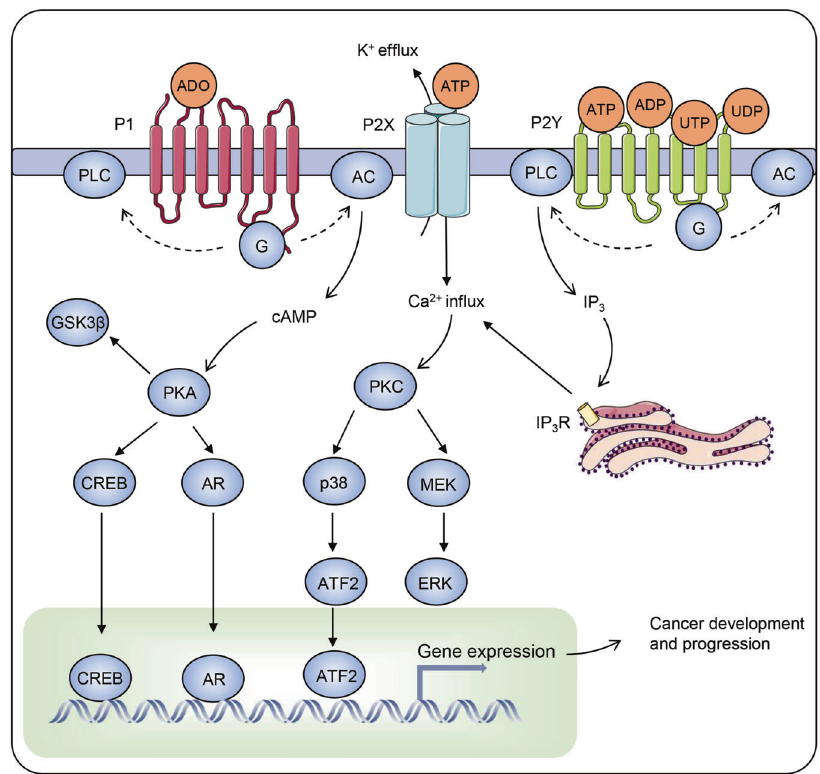
Fig. 6 Purinergic signalling involved in the initiation and progression of cancer. Tumour microenvironment is rich in purines, including adenosine (AD) and other nucleotides. A panel of purinergic receptors are expressed in tumour cells to receive these extracellular purinergic signals. Activation of P1 and P2Y receptors leads to an altered activity of adenylate cyclase or phospholipase C (PLC) by coupling different G proteins (G), whereas activation of P2X receptors generates ion fl uxes. These events change the level of several secondary messengers, such as cAMP, Ca 2 + and InsP 3 . InsP 3 binds to the InsP 3 receptors on endoplasmic reticulum (ER), leading to the release of Ca 2 + from ER. Thus, numerous proteins are regulated by these secondary messengers, including PKA, PKC, GSK3 β , CREB, androgen receptor (AR), MEK, p38, ERK and ATF2. Among them are several transcription factors such as CREB, AR and ATF2, which induce a cancer-related transcription